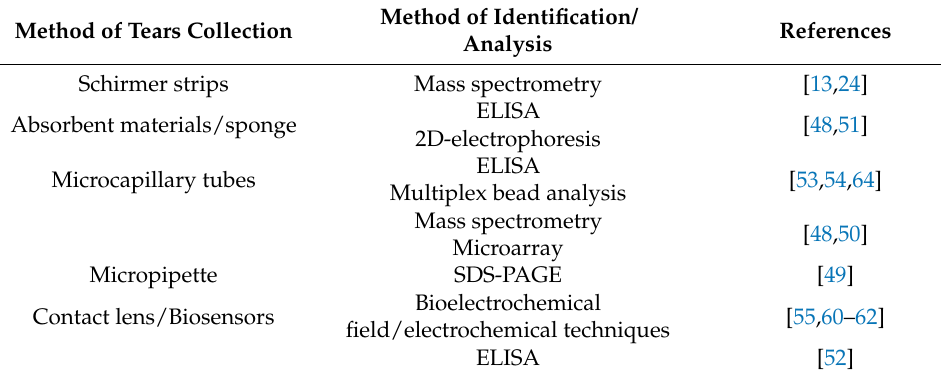
Table 1. Characteristic of tear analysis methods. Method of Tears